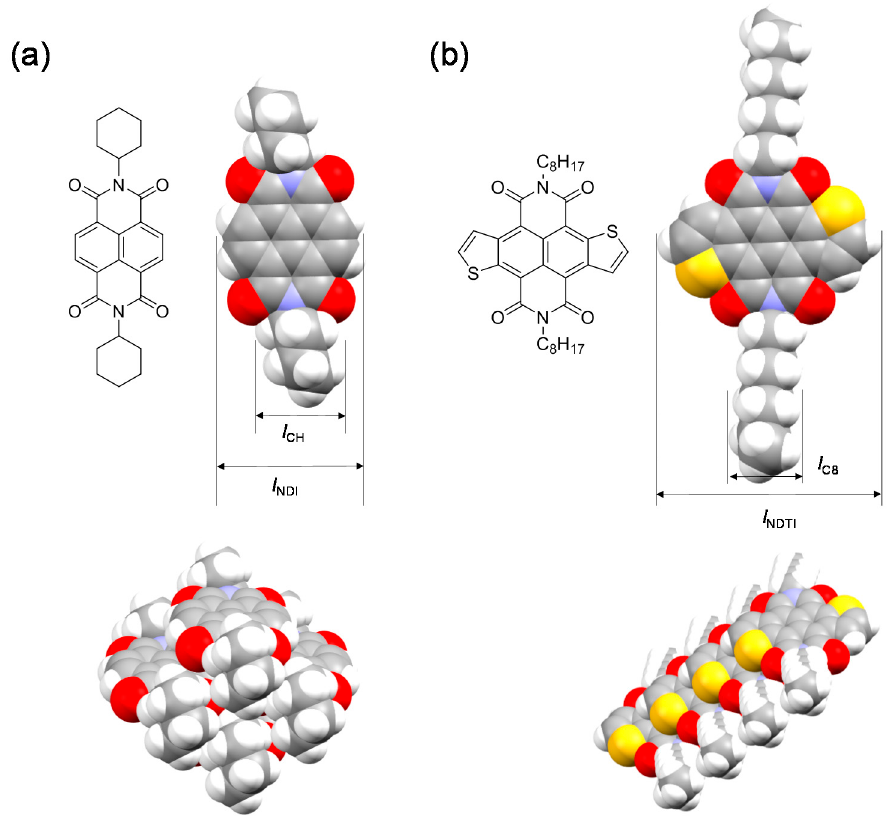
Figure 2. Size comparison of the π -core and the alkyl group and packing structures of N , N ′ -dicyclohexyl NDI (CH-NDI) ( a ) and 1 ( b ) extracted from their single-crystal X-ray structures: l NDI = ca. 6.4 Å, l CH = 3.0 (4.2) Å, l NDTI = ca. 11.2 Å, l C8 = 2.0 (2.5) Å.